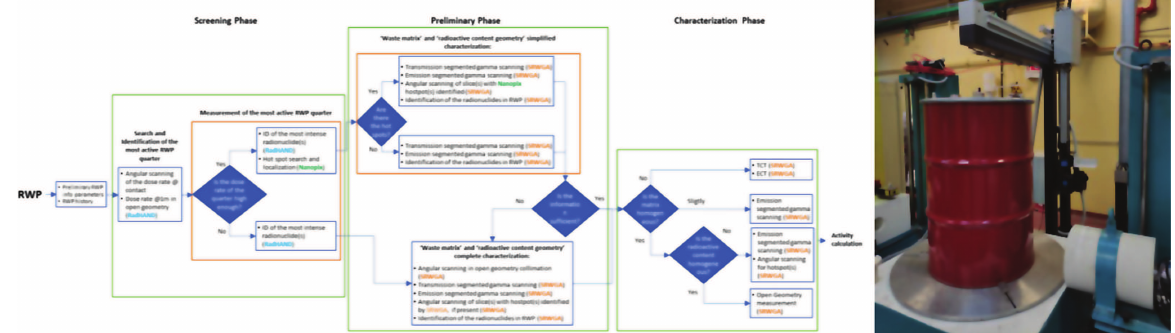
Fig. 6. Gamma station procedure on the left and the integration of the RadHAND sensor with the SRWGA on the right.